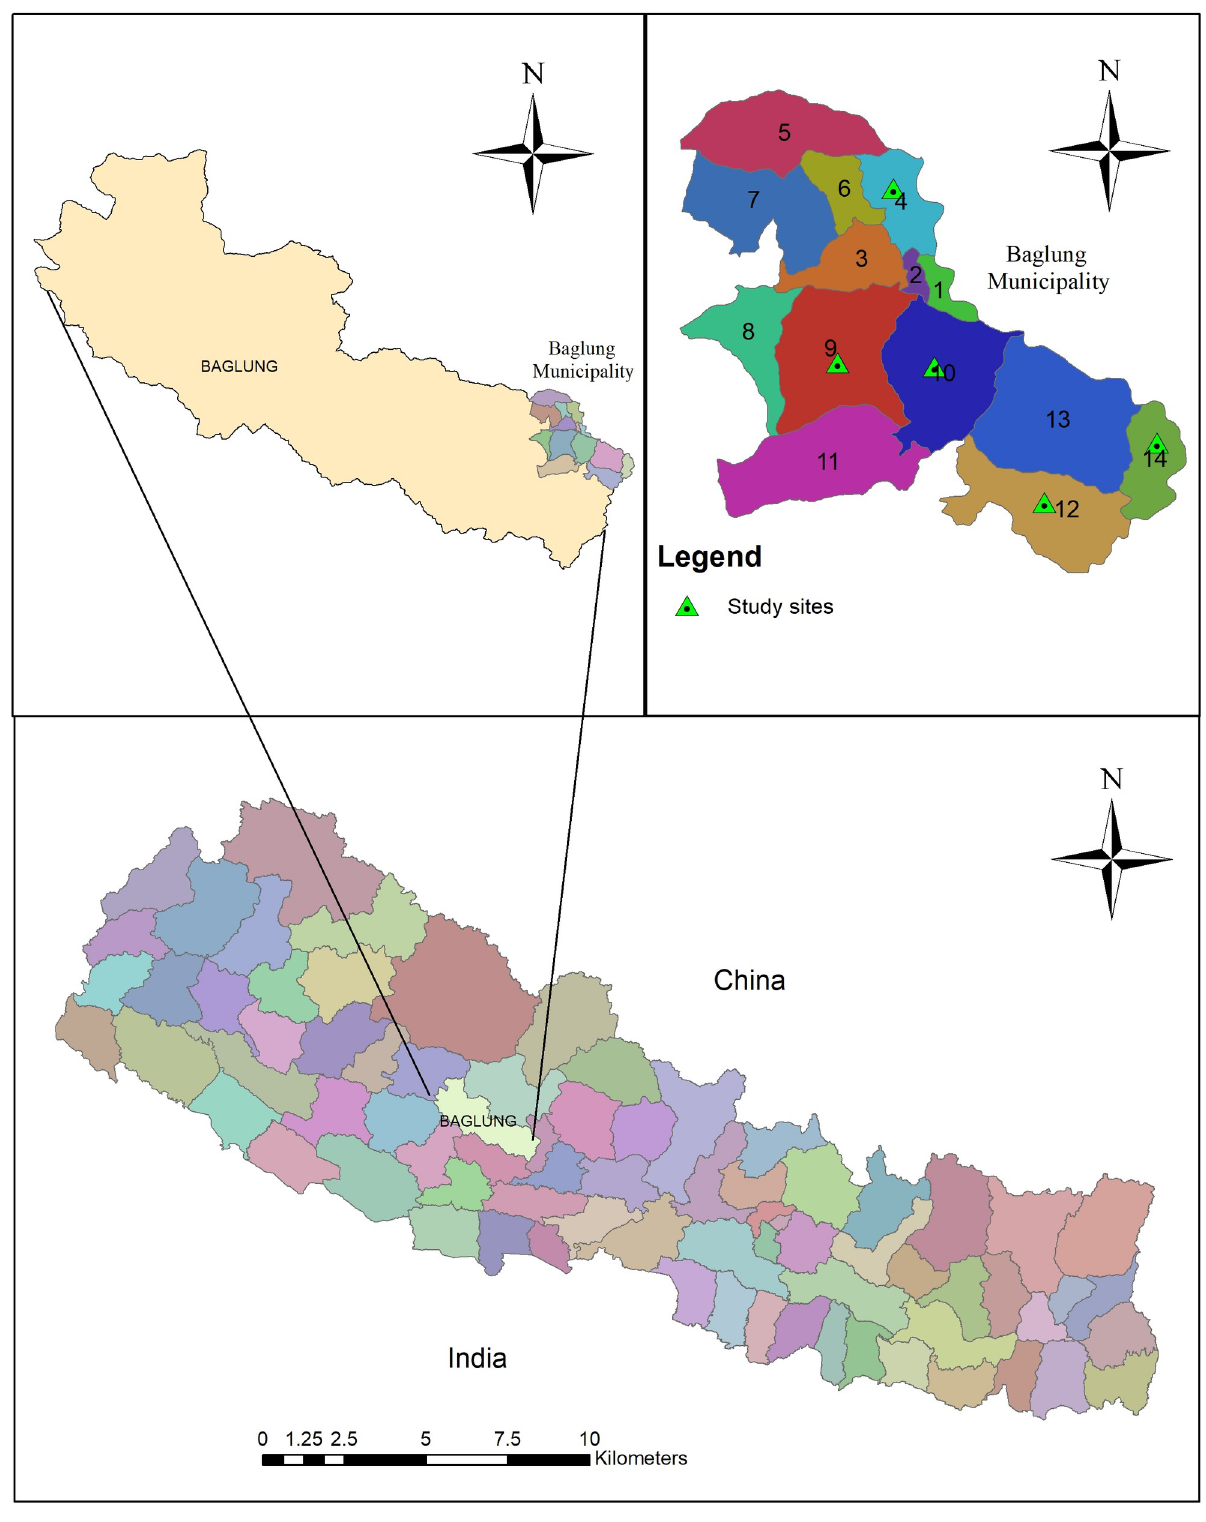
Fig 1. Map showing the location of study sites.